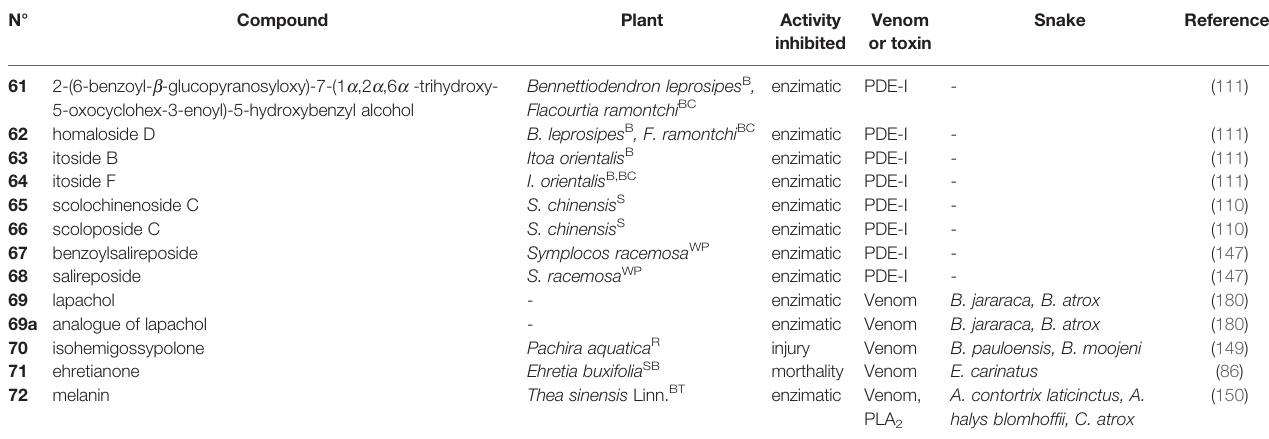
SB, stem bark; R, roots; S, stem; WP, whole plant; B, bark; BC, branches; BT, black tea; Phosphodiesterase I, PDE-I; Phospholipase A 2 , PLA 2 .